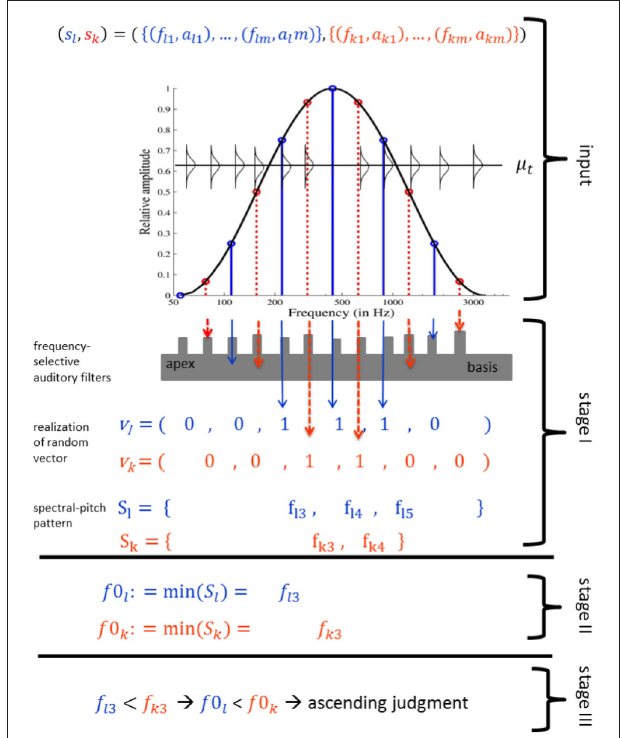
FIGURE 3 | Threshold model algorithm for a Shepard tone pair ( s l , s k ): three components of the first Shepard tone (blue solid line) and four components of the second Shepard tone (red dotted line) are filtered in the first processing stage, resulting in three unfiltered first tone components and two unfiltered second tone components. The frequency of the lowest unfiltered component is assigned the role of fundamental frequency in stage II. Because the first tone fundamental frequency is lower than the second tone fundamental frequency, the model output is an ascending judgment (stage